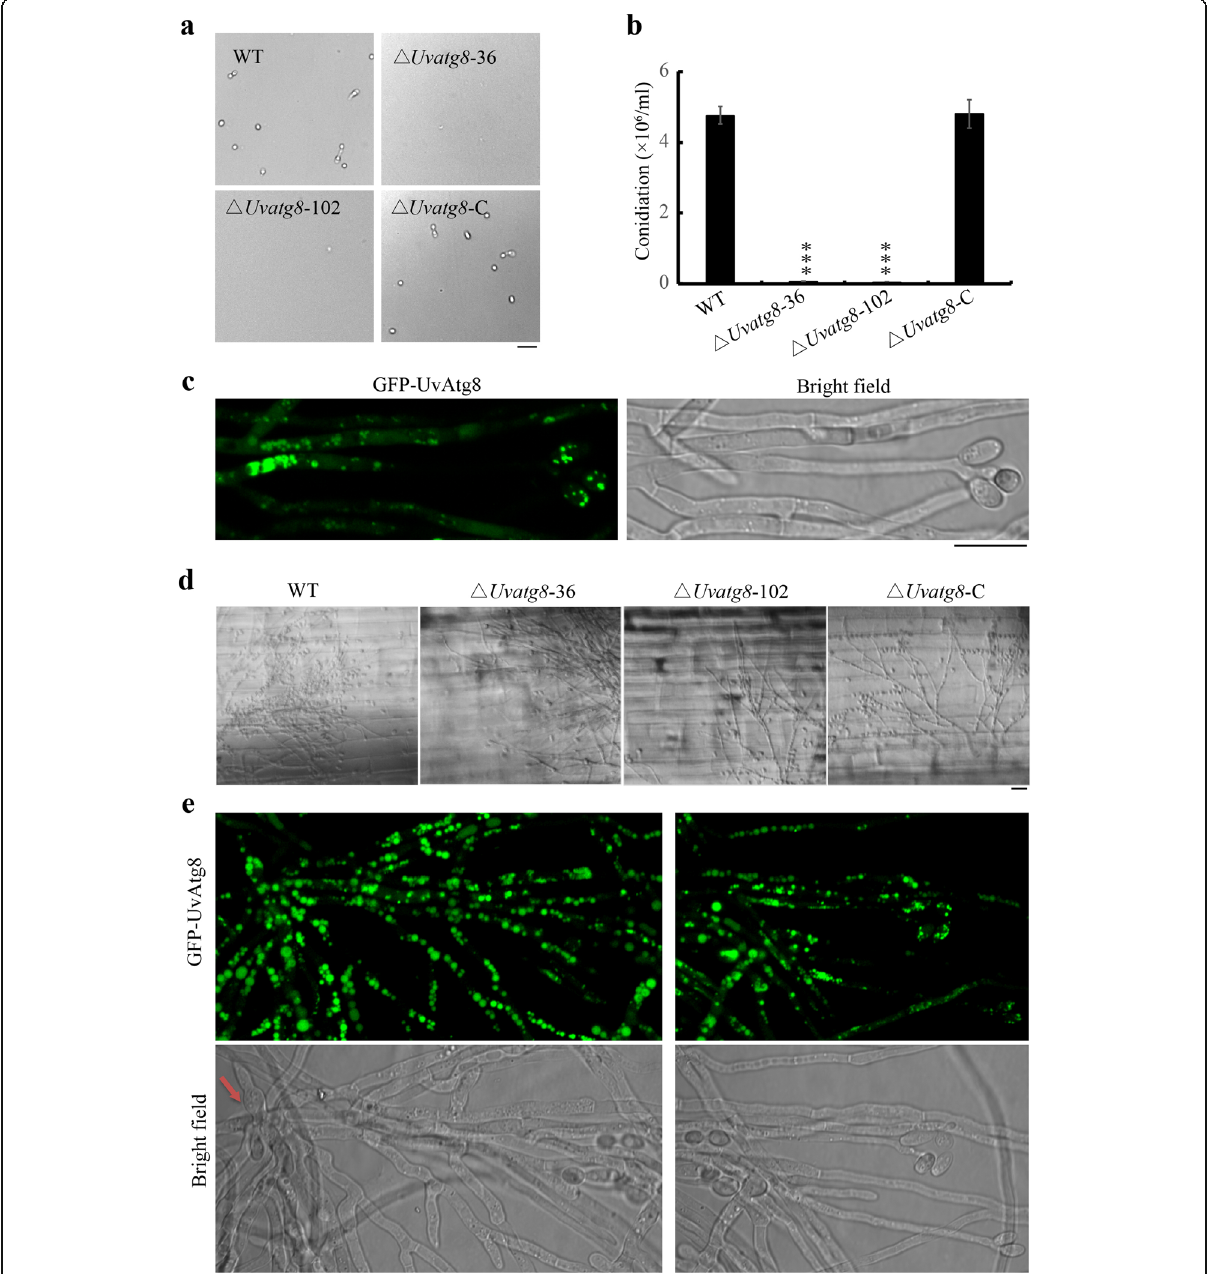
Fig. 7 Deletion of UvATG8 resulted in decreased conidiation. a and b, Conidiation of the tested strains. The strains were cultured in 50 mL of PS medium with 170 rpm at 28 °C for 7 d prior to the observation. Three repetitions were performed, with similar results obtained. c, The expression of GFP-UvAtg8 during conidiation. d, Conidial germination of U. virens on rice sheath. 5 μ L conidial droplets (1 × 10 6 conidia/mL) were inoculated and incubated at 28 °C for 3 d. Photographs were taken under an Olympus BX53 microscope equipped with bright field optics. e, The GFP- UvAtg8 was highly expressed, and autophagy had occurred during the secondary spore formation stage. The images were obtained using a confocal laser scanning microscope. Red arrow showed the conidial germination. Scale bar = 2.5 μ